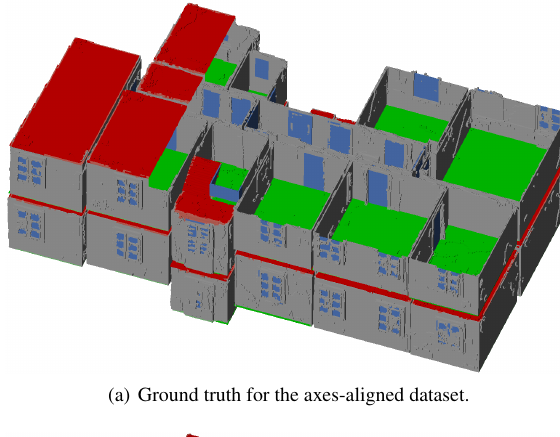
Table 2. Dataset characteristics.